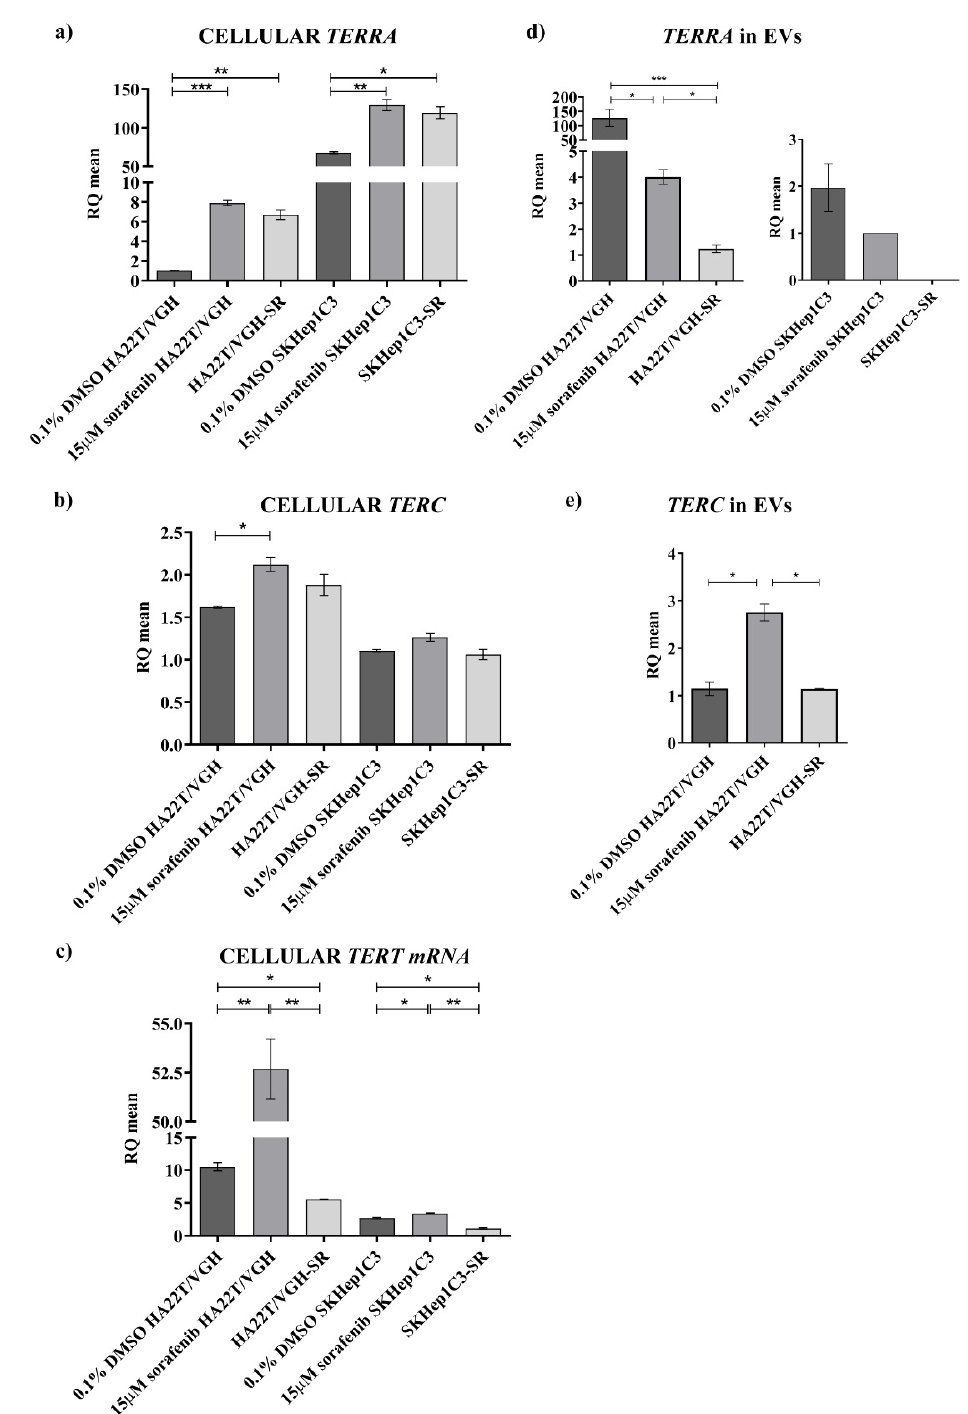
Figure 6. Intra- and extracellular expression of TERRA and telomerase transcripts in HCC cell lines. The expression levels of TERRA ( a ), TERC ( b ) and TERT mRNA ( c ) were measured in HA22T/VGH and SKHep1C3 untreated, resistant to sorafenib (SR) and treated with 15 μ M sorafenib. The levels of TERRA ( d ) and TERC ( e ) were measured in EVs from HA22T/VGH and SKHep1C3 cells untreated, resistant to sorafenib (SR) and treated with 15 μ M sorafenib. As described in Materials and Methods, gene expression level was normalized to the number of particles released per each biological sample, respectively. The histograms represent the mean values of 2 experiments, bars are ± SEM. Unpaired two tailed t -test; * p < 0.05, ** p < 0.01, *** p < 0.001. As shown in Figure 6a, the SK-Hep1 C3 cells express a very high amount of TERRA compared to HA22T/VGH cells (RQ SKHep1C3 = 67.63 vs. RQ HA22T/VGH = 1.03; fold increase, FI =